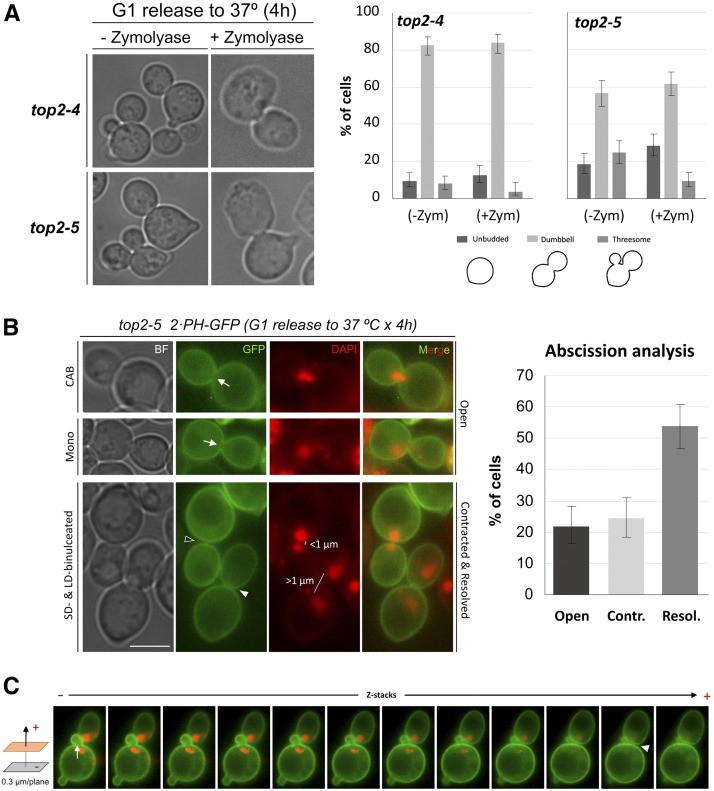
Cytokinesis defects in top2-ts and correlation with the different abnormal nuclear segregation morphologies. (A) The same top2-4 and top2-5 strains used for Figure 2 were synchronized in G1 at the permissive temperature (25°) and then released into a synchronous cell cycle at 37° for 4 hr. A sample was then taken, fixed with formaldehyde, and split in two for addressing cytokinesis through the cell wall digestion assay; i.e., comparing cell morphologies after zymolyase or a mock treatment. On the left, representative pictures of cells for the mock control and zymolyase treatment. On the right, quantification of major cell morphologies. Error bars depict CI95 of the measured percentages. (B) A top2-5 strain expressing the plasma membrane (PM) marker PH-GFP was release in a synchronous cell cycle as in (A). A sample taken after 4 hr was stained with DAPI and visualized under the microscope. On the left, representative cells showing different degrees of cytokinetic completion and their best corresponding nuclear shape across the neck. The arrow points to an “open” neck (no PM ingression) with either a CAB across (first cell) or mononucleated (second cell), the open arrowhead points to a “resolved” membrane at the neck (i.e., abscission with septum deposition in between) with a SD-binucleated nuclear morphology, and the filled arrowhead points to a “contracted” PM. (C) A complete Z-stack series of a representative threesome is shown. Note how the mother and the daughter have a resolved PM at the neck (filled arrowhead), whereas the mother and its second bud have an open neck (white arrow). The bar corresponds to 5 μm. BF, bright field.